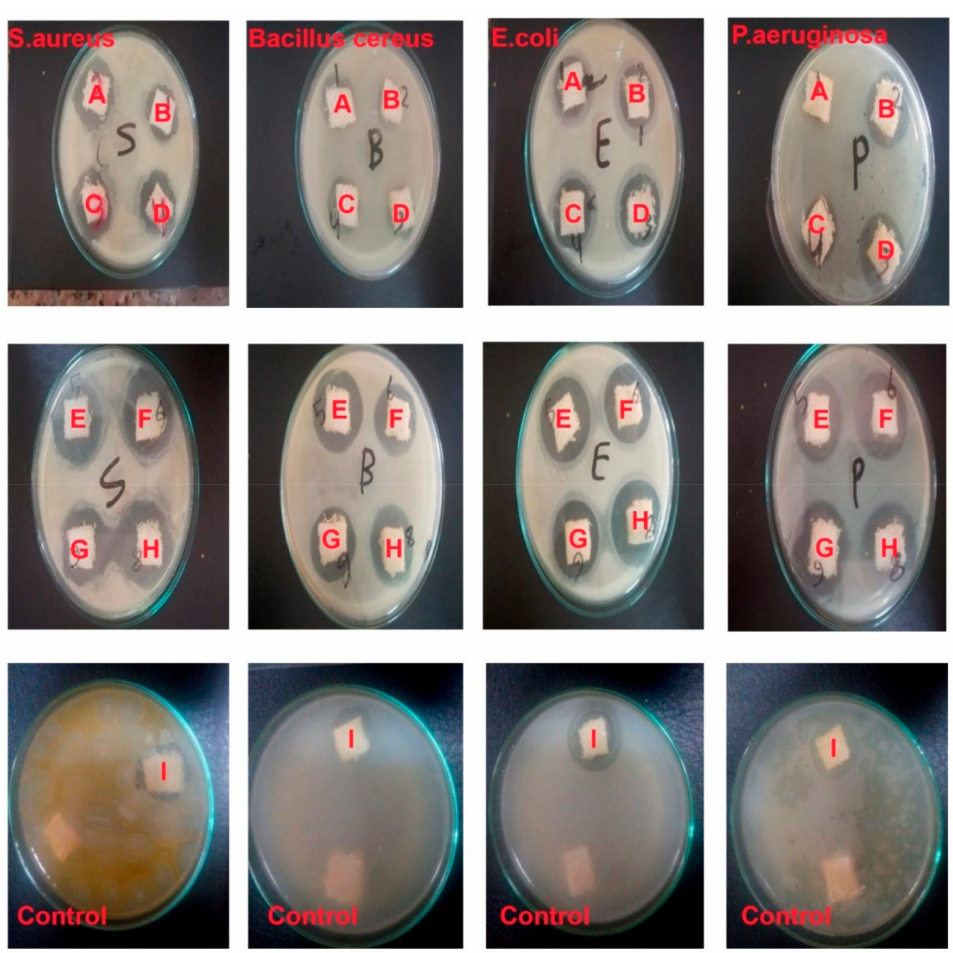
Figure 6. Photograph of Antibacterial Activity of the Blank and SiO 2 NP/Cotton/Lycra